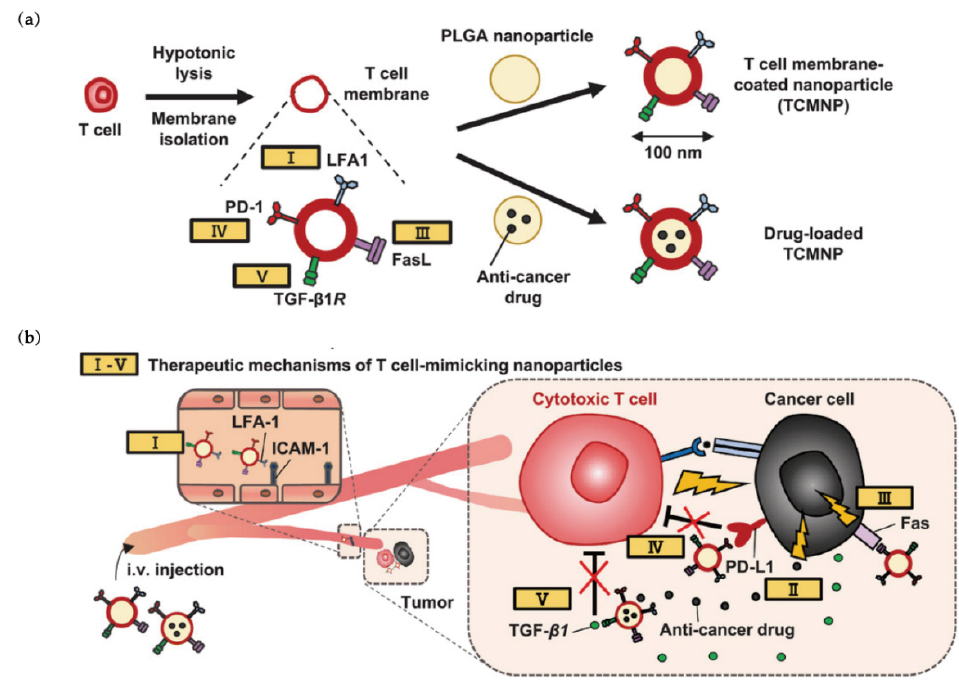
Figure 2. Fabrication and proposed therapeutic mechanisms of TCMNPs. ( a ) Preparation of TCMNPs and anti-cancer drug-loaded TCMNP; ( b ) proposed therapeutic mechanisms of TCMNPs: (I) TCMNPs are actively targeted at tumor by interactions between LFA-1 on TCMNPs and ICAM-1 on inflamed endothelium in tumor tissues; (II) anti-cancer drugs released from TCMNPs; (III) FasL on TCMNPs can directly kill cancer cells; (IV) block the PD-1/PD-L1 signaling; (V) scavenge TGF- β 1. Reprinted with permission from Ref. [16]. Copyright 2020 John Willey and Sons.